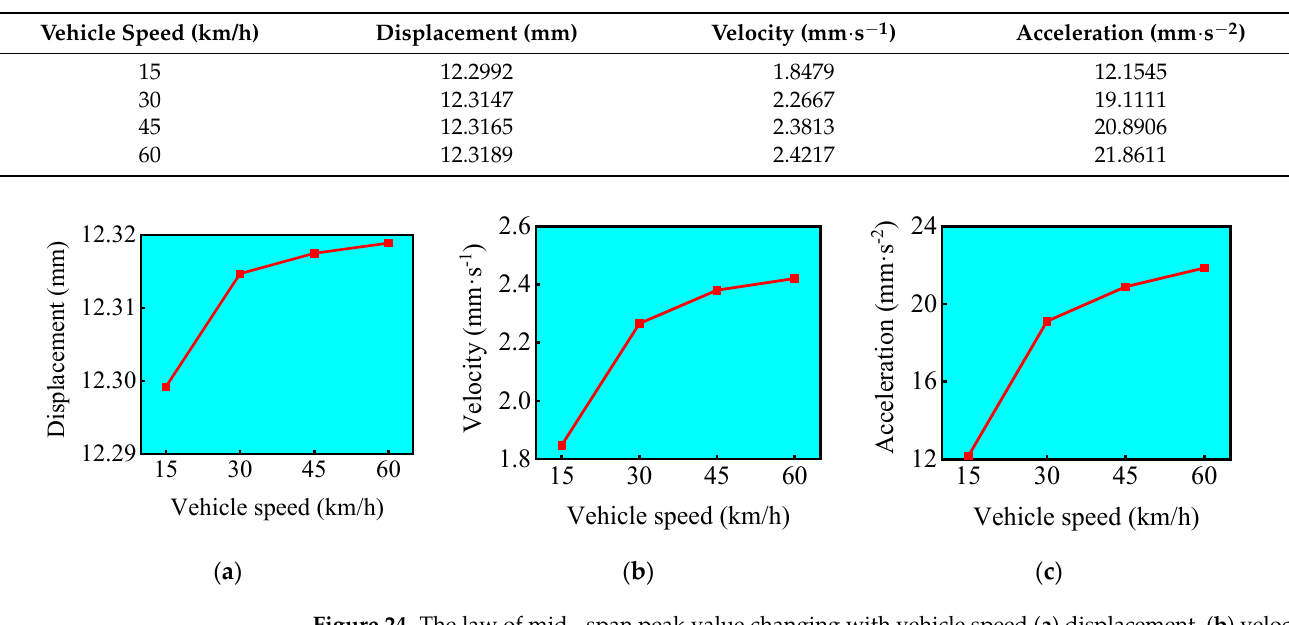
Figure 24. The law of mid − span peak value changing with vehicle speed ( a ) displacement, ( b ) velocity, and ( c ) acceleration.